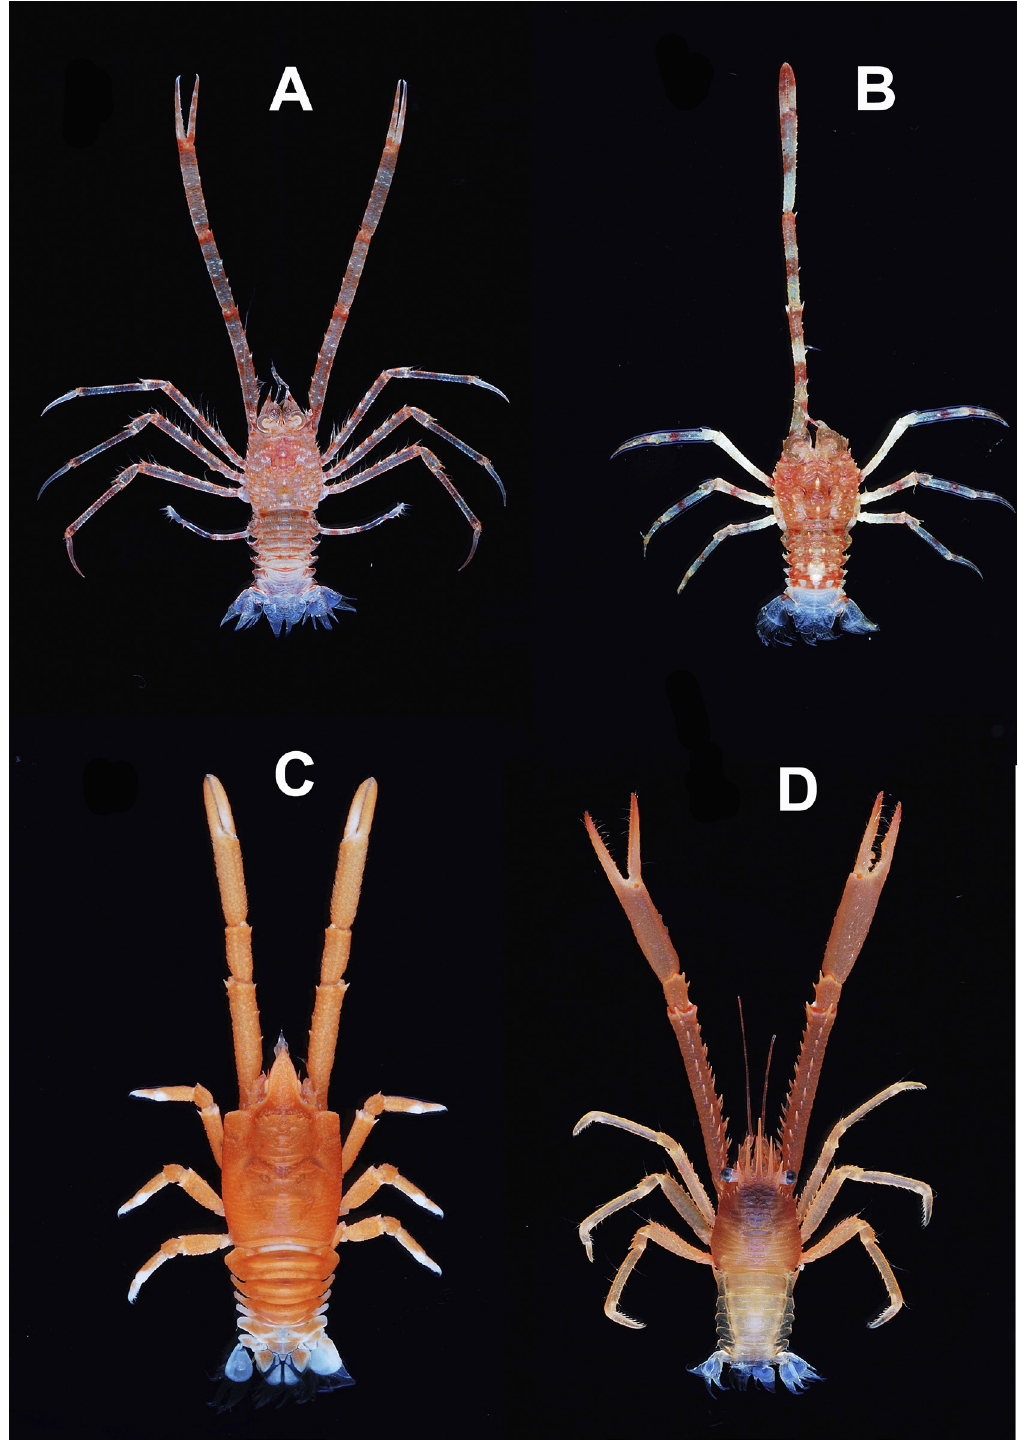
Fig. 14. Dorsal view. Colours in life. A . Paramunida mozambica Cabezas et al. , 2011, ♀, 6.0 mm, Mozambique, MAINBAZA, Stn CP3161. B . Bathymunida polae Balss, 1914, ♂, 3.8 mm, Mozambique, MAINBAZA, Stn DW3133. C . Munidopsis africana Balss, 1913, ♂, 7.4 mm, Mozambique, MAINBAZA, Stn CP3142. D . Eumunida minor de Saint Laurent & Macpherson, 1990, ♂, 5.3 mm, Mozambique, MAINBAZA, Stn